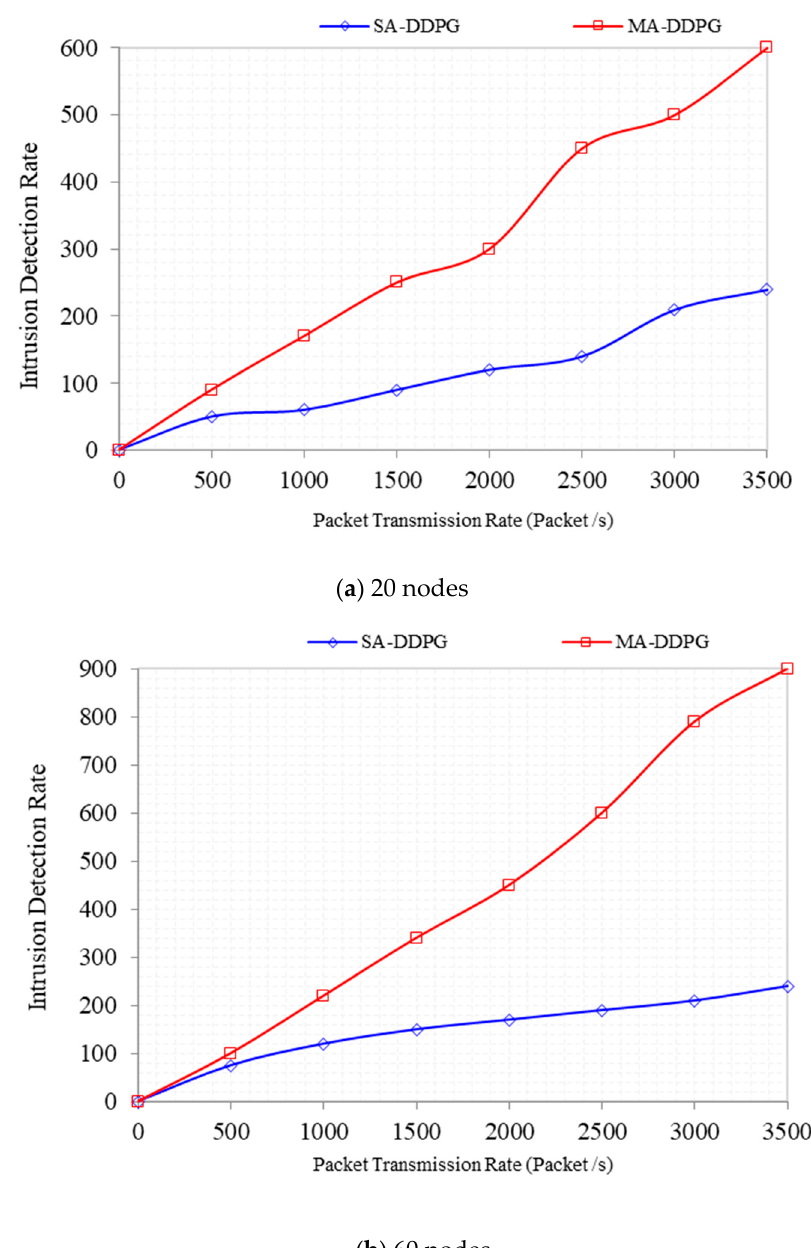
Figure 15. Intrusion Detection Rates vs. Packet Transmission Rate for SA ‐ DDPG and MA ‐